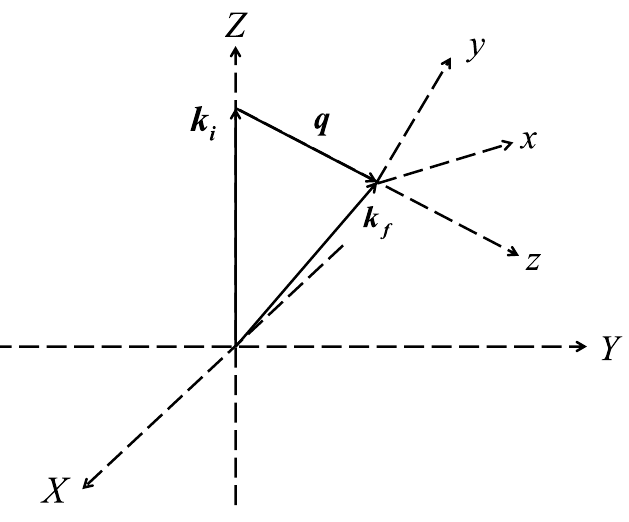
Figure 2 . Coordinate system XY Z and xyz . Coordinate system XY Z is chosen such that the Z axis is along the direction of initial photon γ , and X axis can be chosen as arbitrary direction perpendicular to the Z axis. While the coordinate system xyz is chosen such that the z axis represents the momentum transfer direction. After Compton scattering, the momentum of the scattered photon is denoted as k , and the momentum transfer vector q is defined as q ≡ k f f − k i